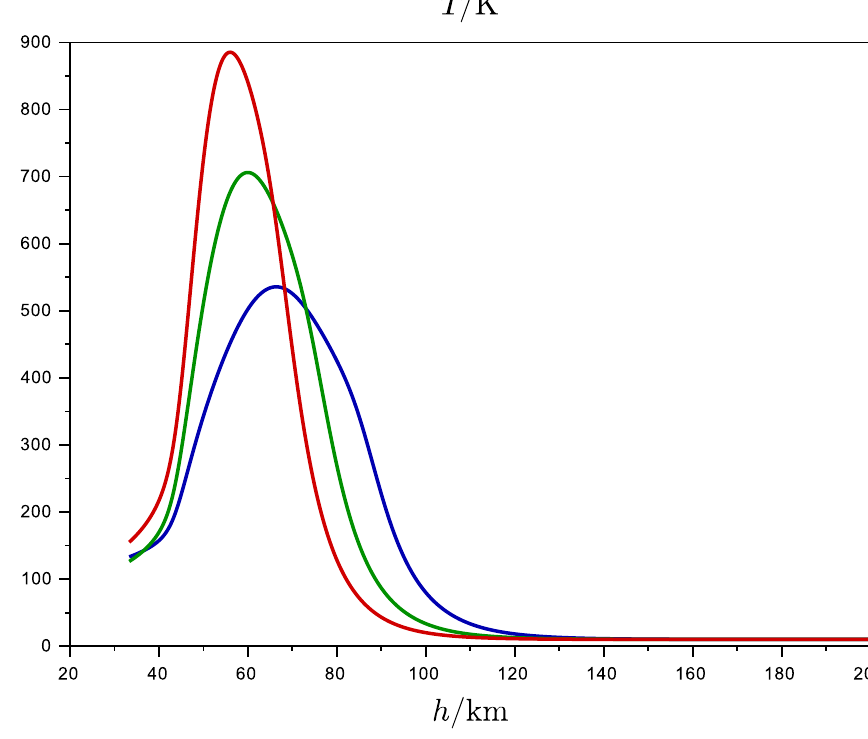
Figure 1. Temperature profile during atmospheric entry versus altitude for micrometeoroids of initial radius 10 µ m (blue), 30 µ m (green), and 70 µ m (red) ( v 0 = 3.7 km s − 1 , θ 0 = 45.0